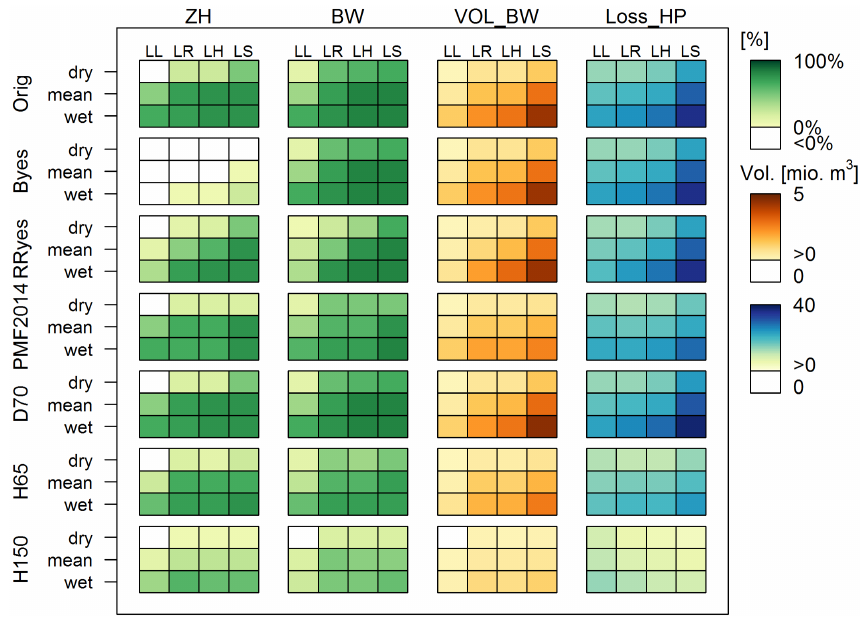
Figure 5. Effect of single management procedures (main rows) as function of different combinations of initial conditions (sub-rows and sub-columns) for different criteria (main columns, cf. last paragraph of Sect. 3). More details on the used notations in Sects. 3 and 4.2 and in